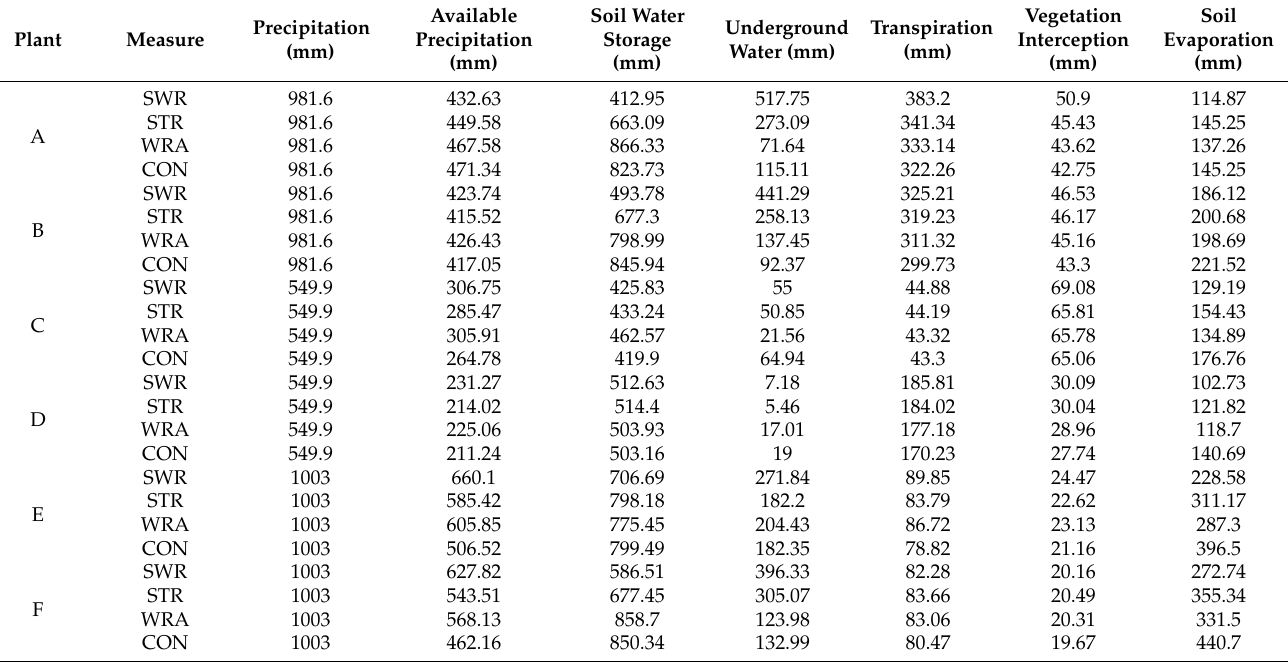
Table 3. Storage and transformation of water